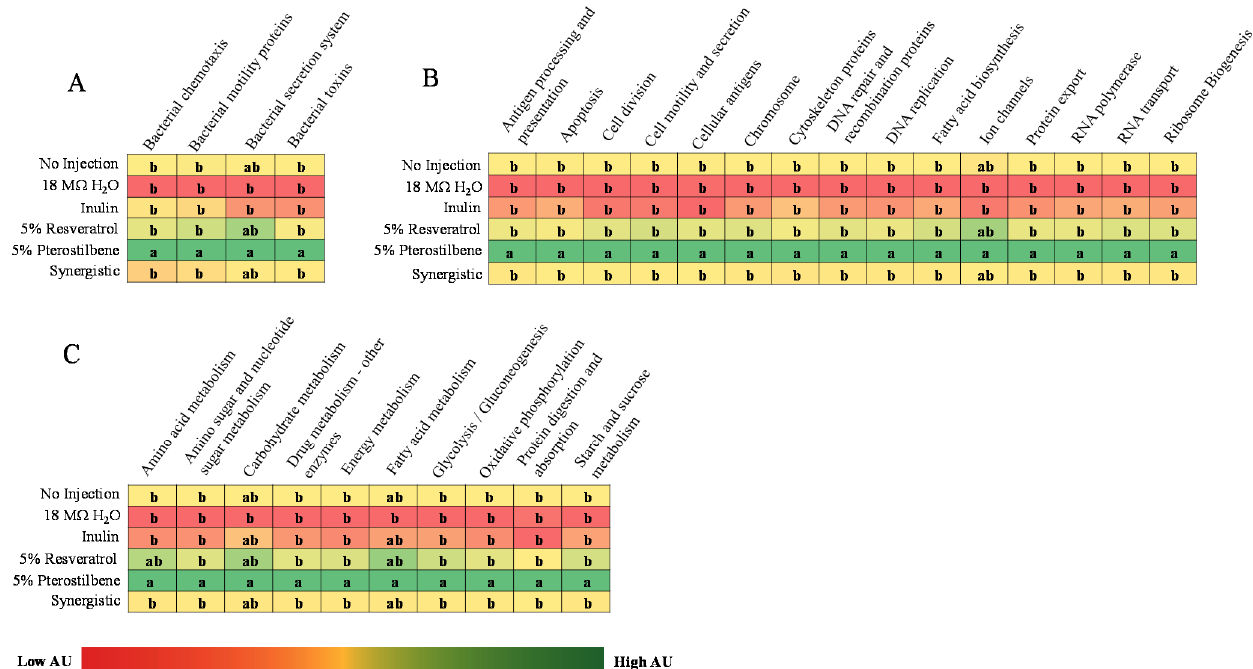
Figure 6. Relative significance of differentially enriched microbial metabolic pathways in cecal microbiota after the intra- amniotic administration of stilbenes. ( A ) Bacterial processes. ( B ) Cellular processes. ( C ) Metabolic processes. a–b Treatment groups not indicated by the same letter are significantly different by ANOVA ( p < 0.05).